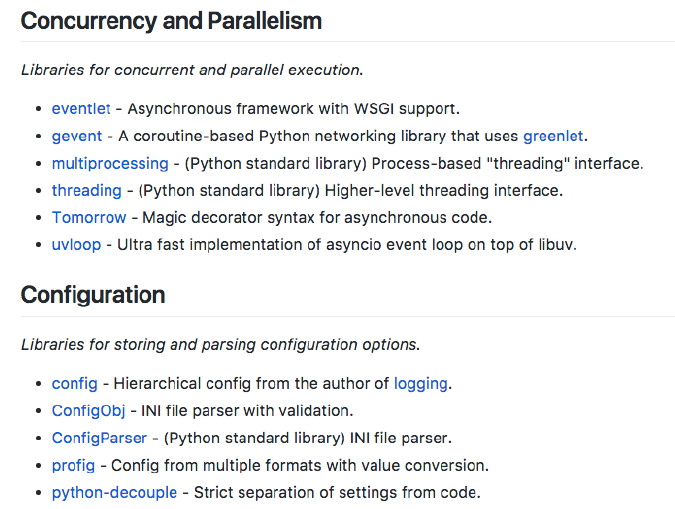
Figure 1. The “awesome Python” curation repository (https://github.com/vinta/awesome-python). RQ1 : How are curation repositories different from the typical software repositories of GitHub?